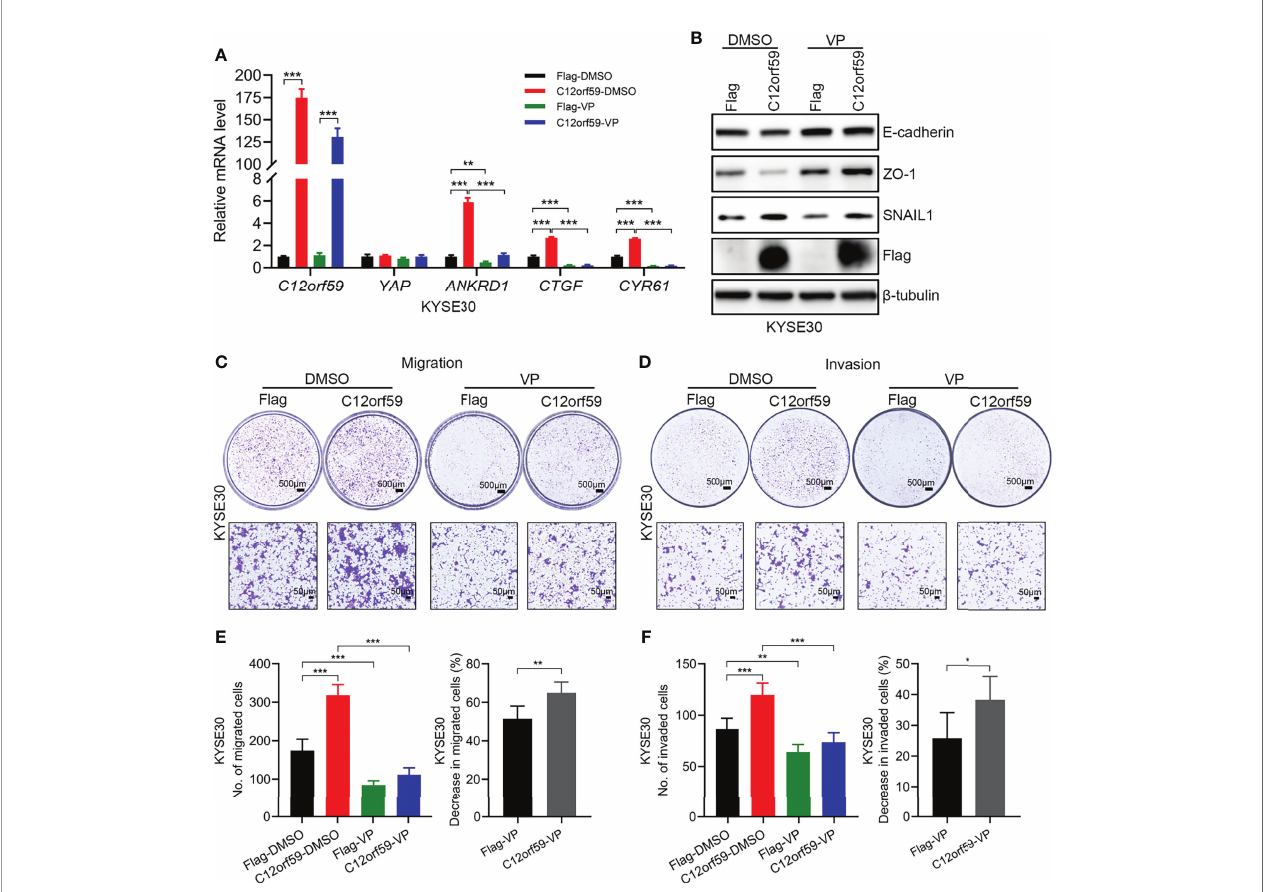
FIGURE 6 | C12orf59 contributes to the EMT and cellular motility of ESCC cells via YAP activation. (A) Real-time PCR was used to analyze the mRNA levels of C12orf59, YAP, and YAP target genes ( ANKRD1 , CTGF , and CYR61 ) in control and C12orf59-overexpressed KYSE30 cells treated with or without vertepor fi n (YAP inhibitor, 2.5 m M) for 6 h. RPL19 was used as the internal control for real-time PCR. (B) Western blotting was conducted to analyze the protein levels of EMT markers (E-cadherin, ZO-1, and SNAIL1) in control or C12orf59-overexpressed KYSE30 cells in the absence or presence of vertepor fi n. b -tubulin was used as the loading control for western blotting. (C, D) Transwell assays were used to inspect the effect of YAP inhibition by vertepor fi n on cell migration and invasion in control or C12orf59-overexpressed KYSE30 cells and representative images were shown. Scale bar, 500 m m for low and 50 m m for high magni fi cation. (E) The number of migrated cells and the percentage of reduction in cell migration induced by vertepor fi n was counted, calculated, and quanti fi ed. (F) The number of invaded cells and the percentage of reduction in cell invasion induced by vertepor fi n was counted, calculated, and quanti fi ed. Data were presented as mean values with standard deviations, * p < 0.05; ** p < 0.01; *** p <